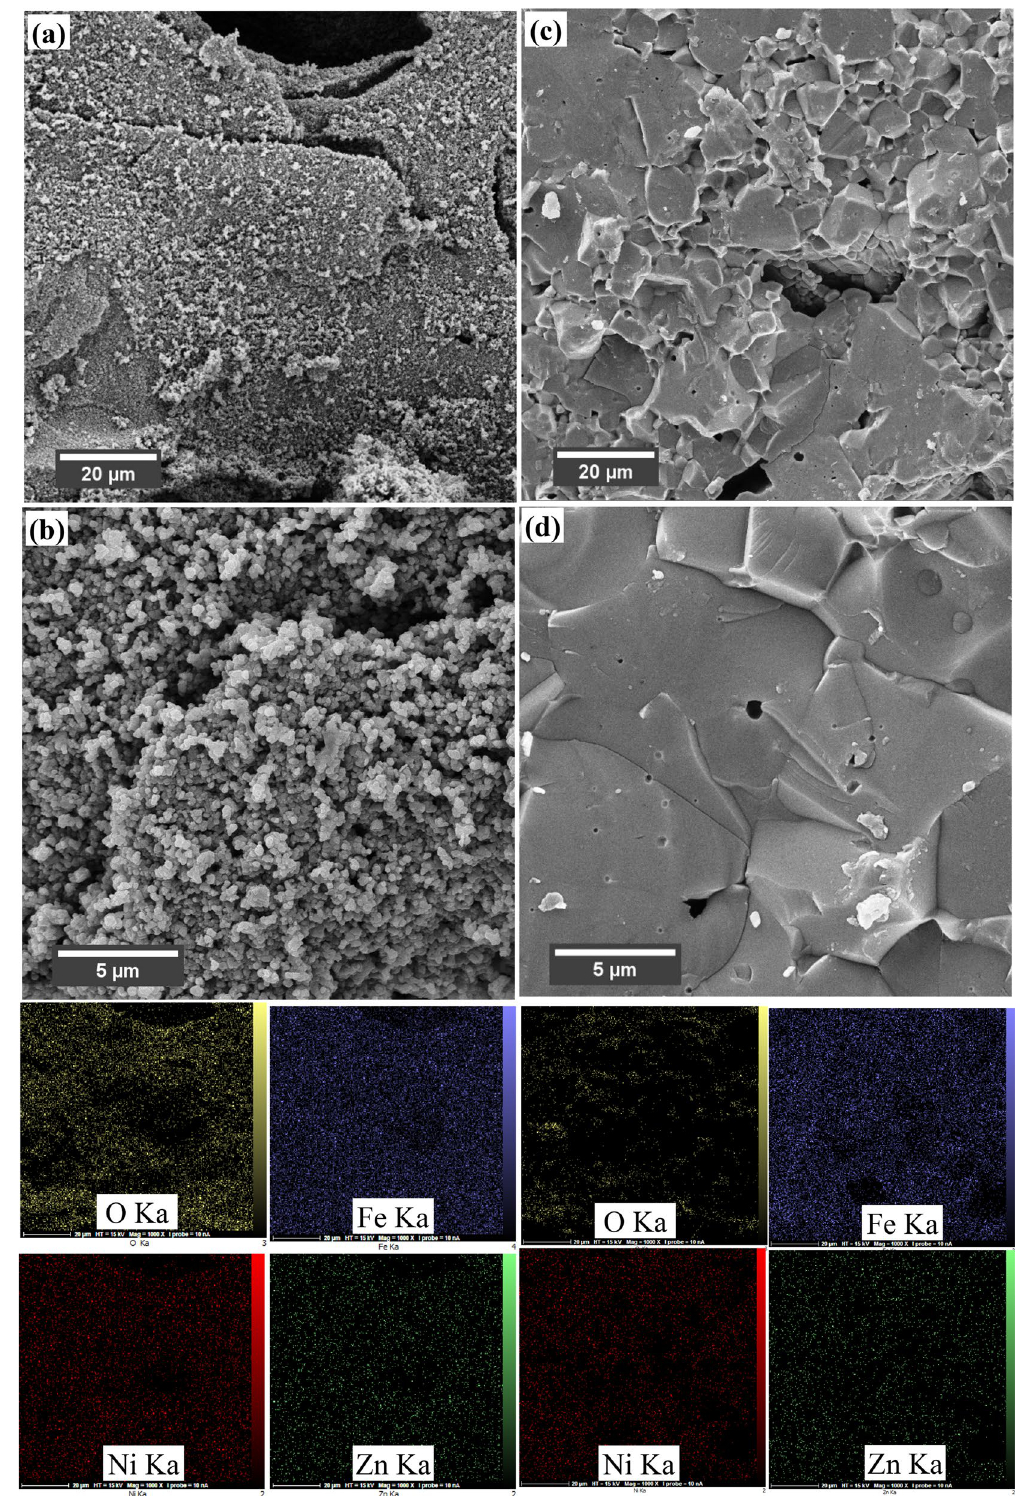
Figure 5. SEM micrographs and EDS maps of the samples sintered at ( a , b ) 1100 and ( b , c ) 1300